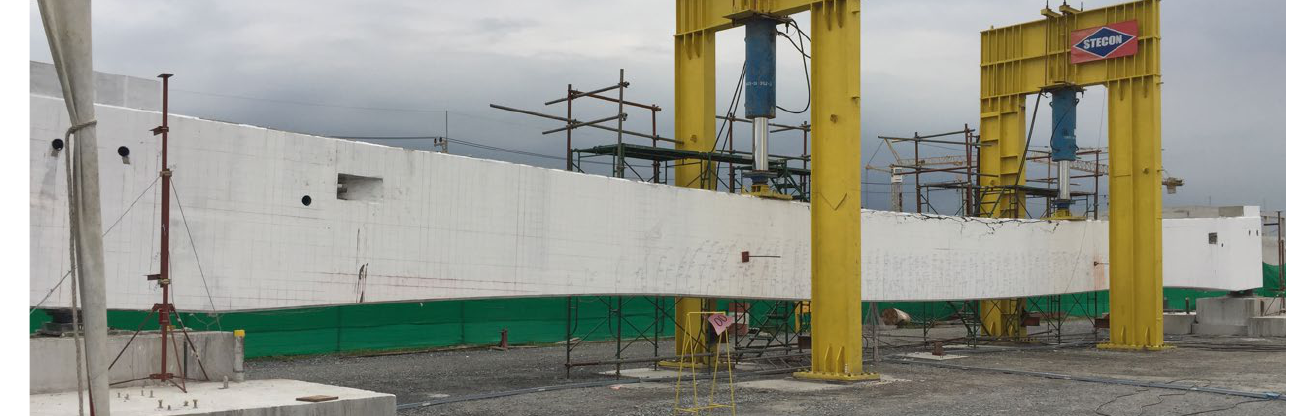
Buildings 2022 , 12 , x FOR PEER REVIEW Figure 51. Ultimate failure of specimen SP-2. Figure 51. Ultimate failure of specimen SP-2.